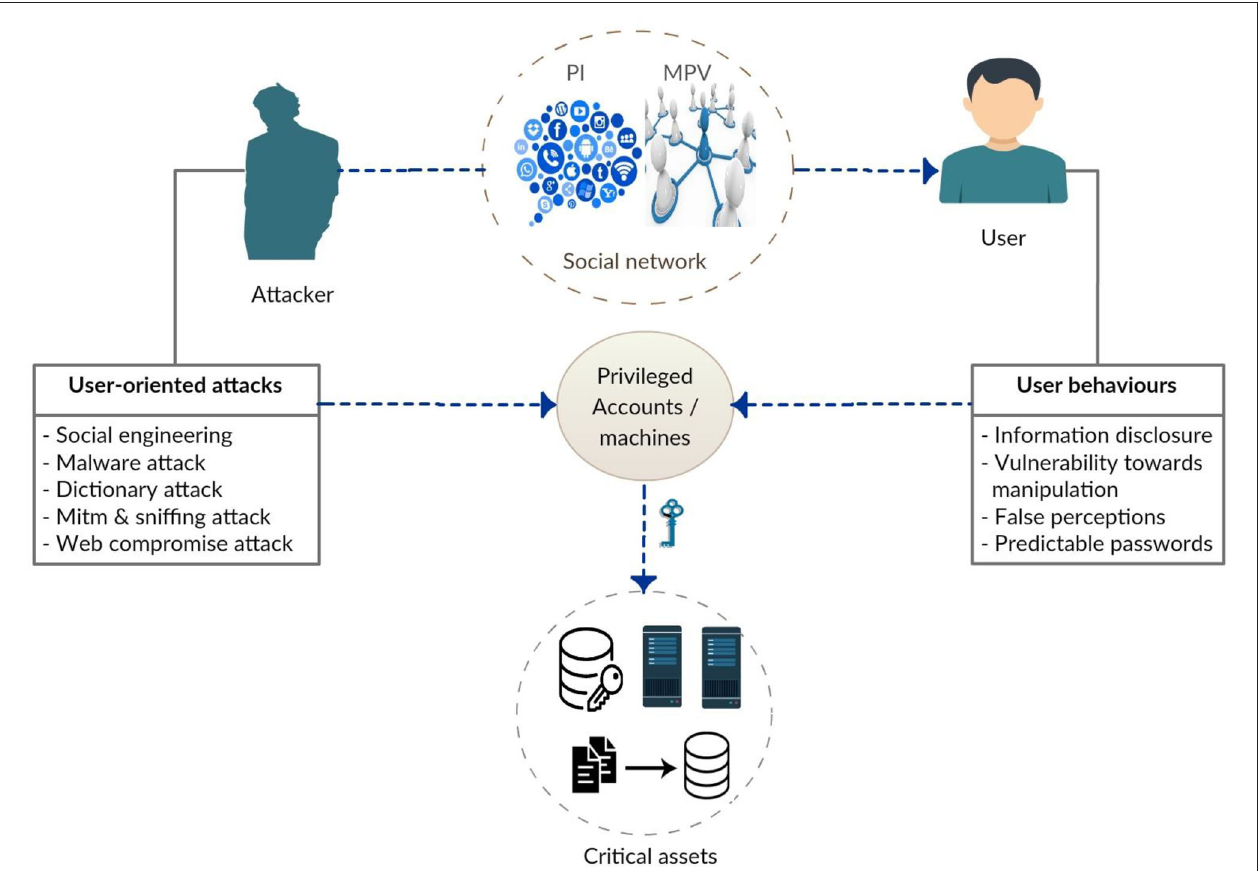
FIGURE 3 | The architecture of a user-oriented attack. PI, Privacy Invasion, MPV, Multi-Party